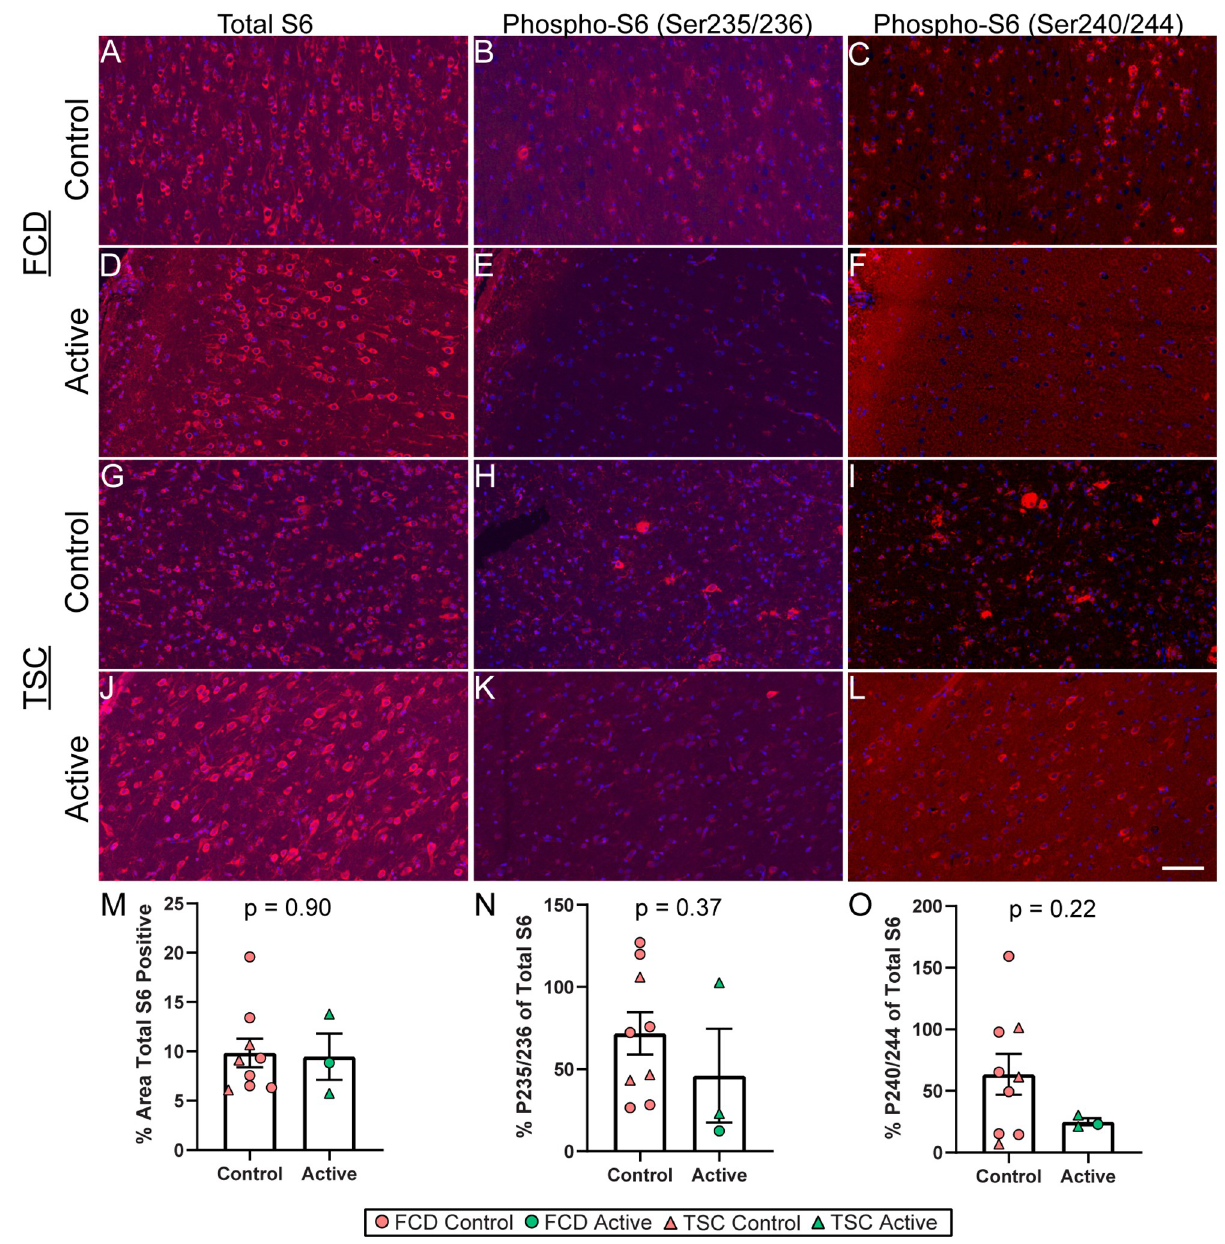
Fig 2. Histological quantification of ribosomal S6 phosphorylation in gray matter. Representative images show total S6, phospho-S6 (Ser235/236), and phospho-S6 (Ser240/244) (red) in resected cortical tissue from FCD participants that were Controls A-C) or Active D-F) and in TSC participants that were Controls G-I) or Active J-L). M) Quantification of total S6 expression in the gray matter indicated no difference in baseline expression between Active and Control participants. N) Quantification of percent phospho-S6 (Ser235/236) relative to total S6 in the gray matter indicated an average 1.56-fold decrease when comparing all Active participants to Controls (p = 0.37). O) Quantification of percent phospho-S6 (Ser240/244) relative to total S6 in the gray matter indicated an average 5.55-fold decrease when comparing all Active participants to Controls (p = 0.22). Histology was performed on all cases with available FFPE, excluding 1 Active FCD case. Error bars indicate SEM. Scale bar represents 100 μ m.